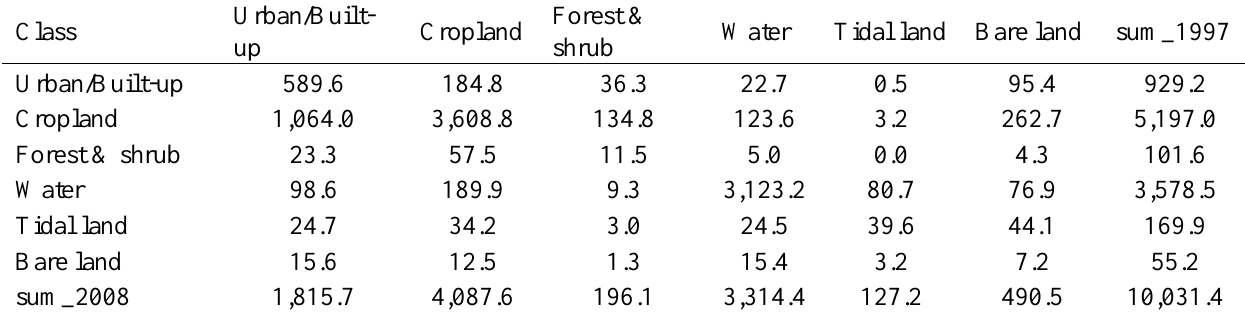
Table 7. Land use transformation matrix in 1997–2008 (unit: km 2 ).